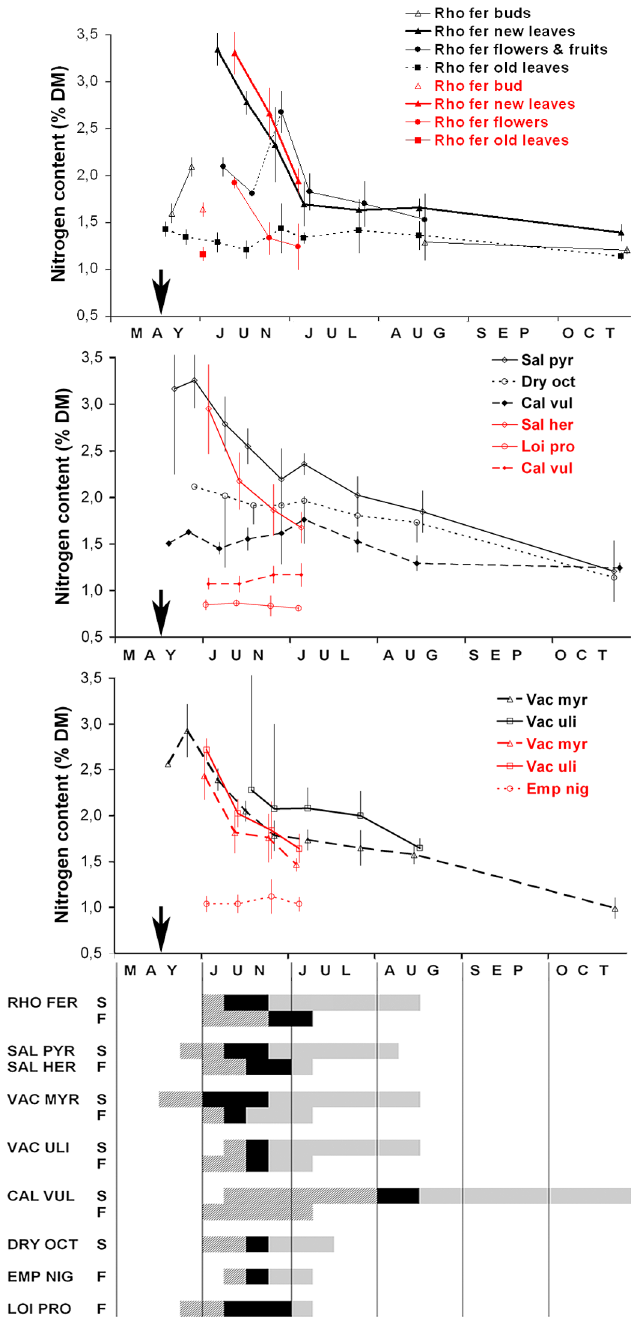
Fig 2. Temporal variation of mean N content (% DM) of the main food species and plant parts of Pyrenean rock ptarmigan in Canigou Massif, France, Eastern Pyrenees (in red) and Calcilarruego, Spain, Middle Pyrenees (in black) during growing and vegetative periods. Species and plant parts are distributed in several figures for clarity reasons. Snowmelt dates are marked by arrows: 16 and 19 May for French and Spanish locations respectively. Plant parts are current year leaves unless otherwise indicated. Vertical bars are 95% confidence limits (only for points with n > 3). Below: average phenological stage of sampled species from Spanish (S) and French (F) locations: white, senescence; striped, growing; black, flowering; hatched, fruiting. Species are denoted by the three first letters of genus and species name (see full name in Material and